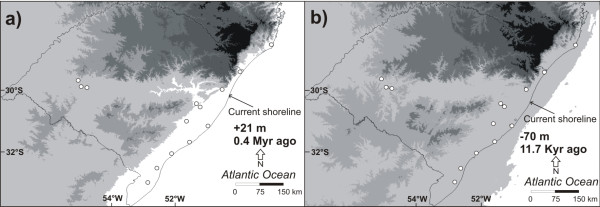
Sea level changes before and during South Atlantic coastal plain formation. Approximate paleogeographic reconstruction of sea level, based on reports in the literature and plotted on current data of altitude and bathymetry. The white circles identify the position of the current Calibrachoa heterophylla populations studied in this work. a) Maximum transgressive event which led to the formation of Barrier–Lagoon System I, Middle Pleistocene, 0.4 Myr ago, 21 m above current sea level [45]. b) The Pleistocene-Holocene transition, 11.7 Kyr ago, 70 m below current sea level [51]. The Patos and Mirim Lagoons are not shown because there are no accurate data about their conformation in this period.